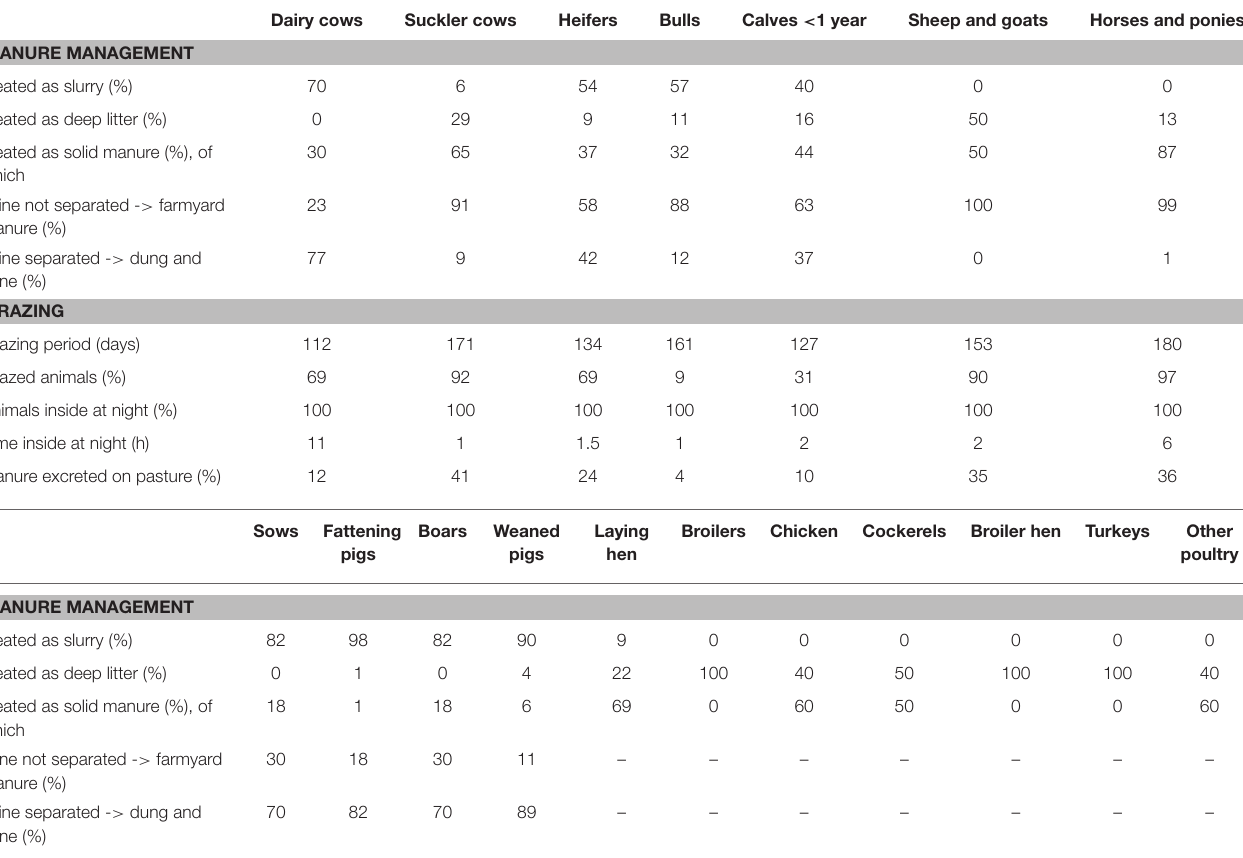
TABLE 3 | The share of different manure types produced and grazing data in Finland (% of manure per each manure type and animal category; Grönroos et al., 2017). Dairy cows Suckler cows Heifers Bulls Calves < 1 year Sheep and goats Horses and